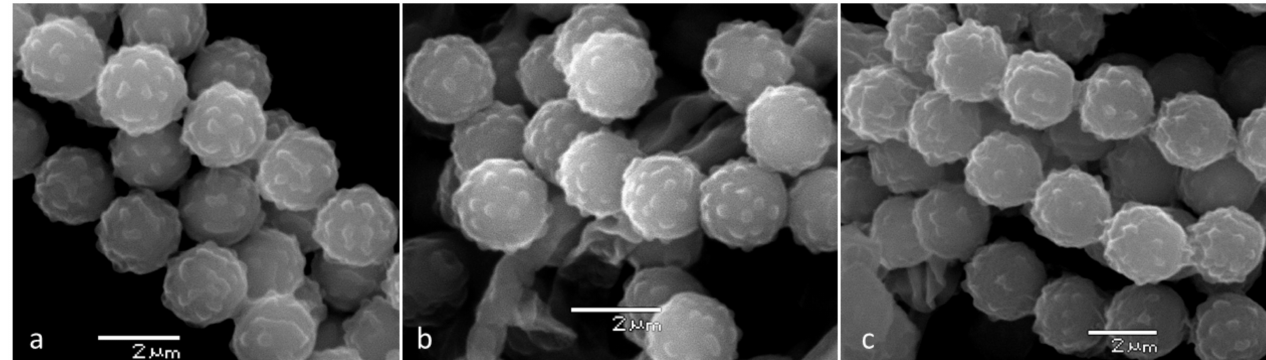
Figure 4. Scanning electron microscopy (SEM) of conidia (on MEA, 20 days) showing tuberculate ornamentation in ( a ) Penicillium chalabudae CBS 219.66 and ( b ) P. kurssanovii CBS 625.67, and aculeate-echinulate ornamentation in ( c ) Penicillium restrictum CBS 367.48.